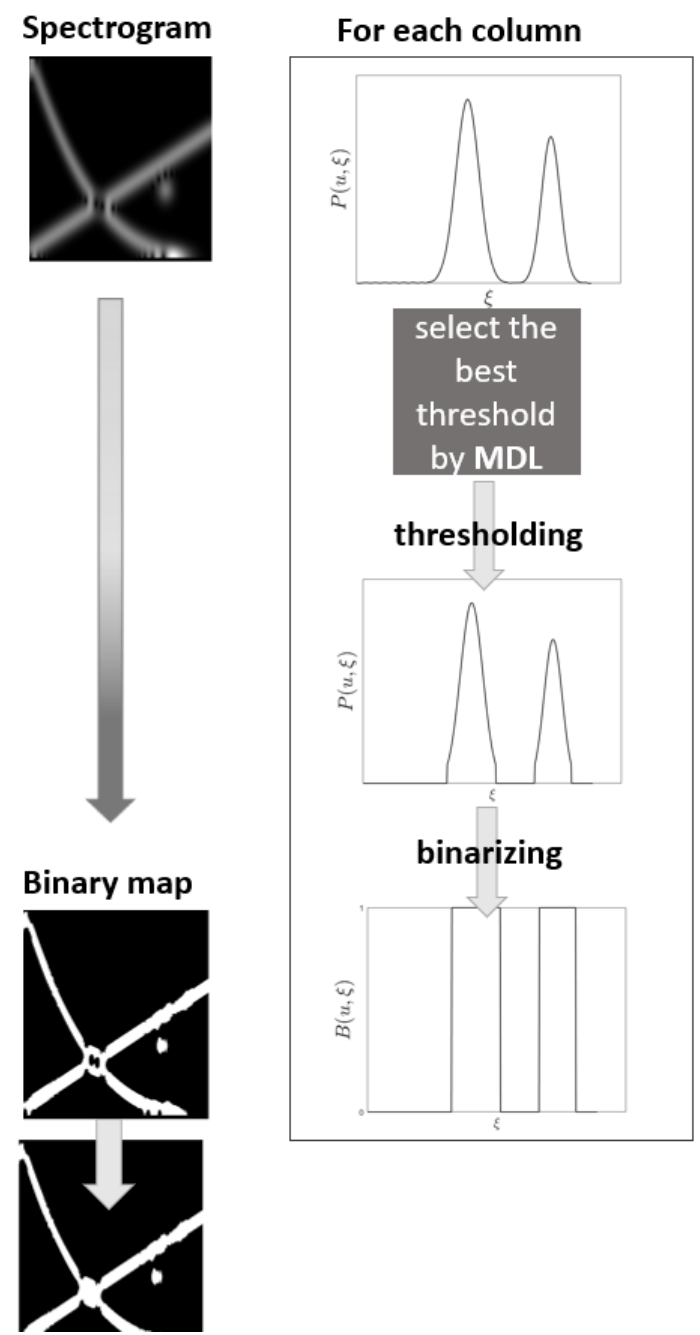
Figure 9. Flow-chart of the algorithm. Step 1: Binary map derivation and its post-processing (i.e., zero-padding and black holes